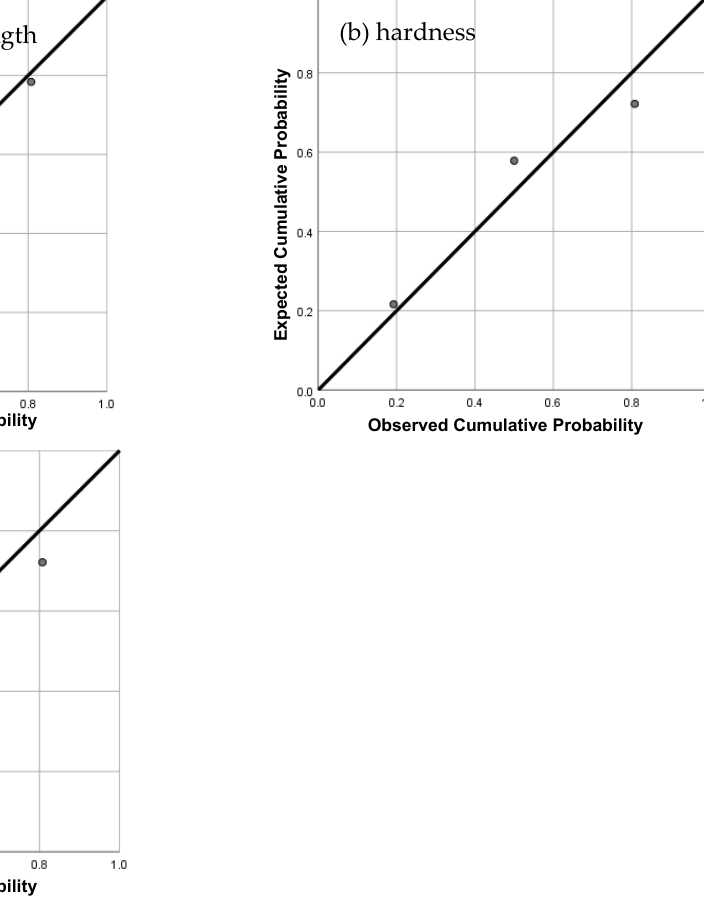
Figure 3. Normal probability plots of the properties of martensitic stainless steel: ( a ) ultimate tensile strength; ( b ) hardness; ( c ) impact toughness. Table 23. Chemical composition of AISI 4140 ferritic stainless steel (% by weight)